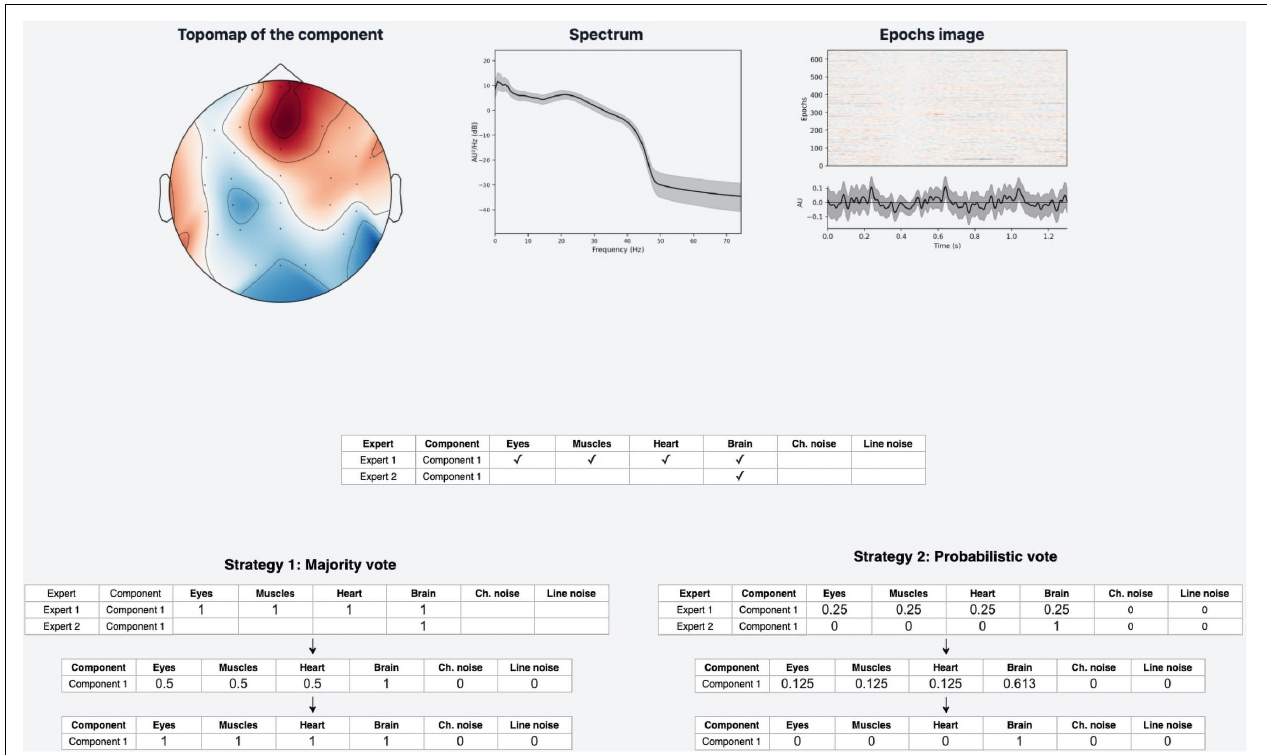
FIGURE 5 | Discrepancies in experts’ opinions and difference in strategies handling. Experts may have different approaches in labeling samples with mixed nature of activity. Expert 1 marked such components with all activity types that are present in the component. Expert 2 instead focused on the components that have a clear pattern of a single IC class. Within a provided example we can see how the difference in their approaches lead to different annotations for the same IC component. The application of “Majority vote” and “Probabilistic vote” strategies for the suggested example affect significantly the final label of the component. With the first one the component corresponds to many IC classes, while in the second case the component is assigned only as a Brain